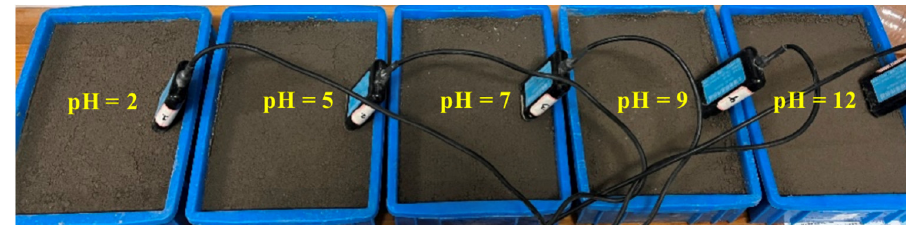
Figure 3. Soil moisture sensor in vegetated soil.